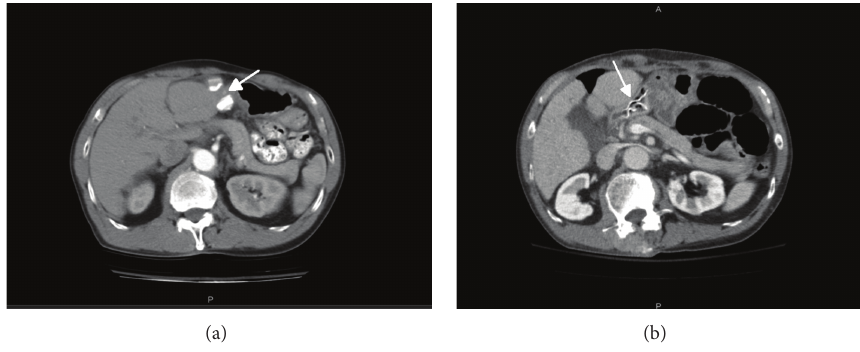
Figure 1: (a) Left, computed tomography scan 7 years after resection, showing the mesh (arrow) extraluminal to the stomach and duodenum. (b) Right, the mesh (arrow) migrated intraluminally 2 years